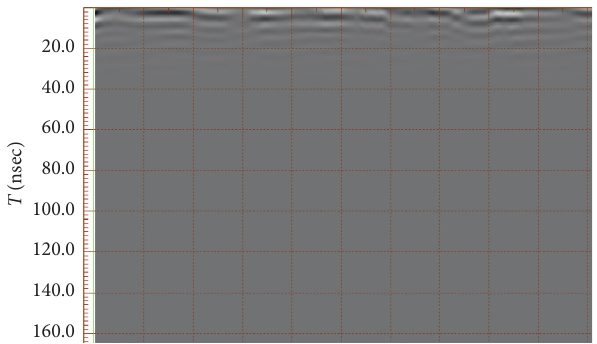
Figure 13: Radar image converted with the default wave velocity of